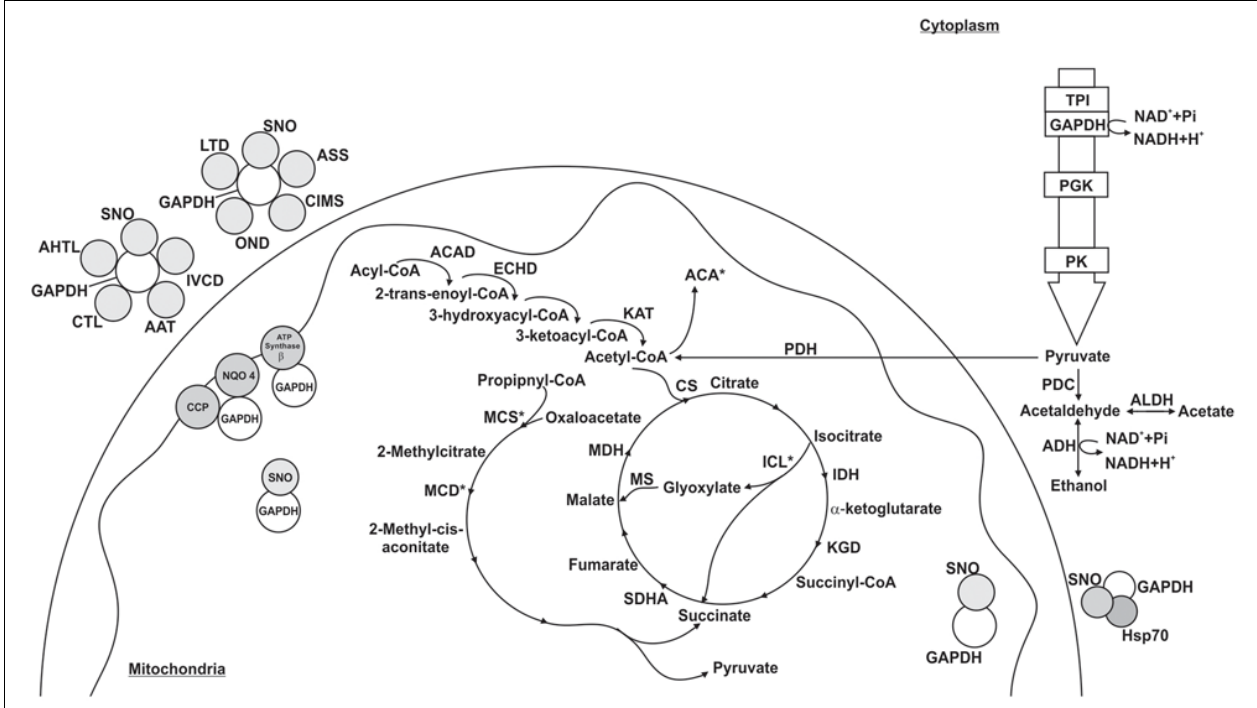
FIGURE 5 | Schematic model of the metabolic processes involving GAPDH through PPI in P. lutzii yeast phase. All proteins shown in the figures interacted with GAPDH. GAPDH (glyceraldehyde-3-phosphate dehydrogenase), SNO (nitrosylation), ACAD (acyl-CoA dehydrogenase), ECHD (enoyl-CoA hydratase), KAT (3-ketoacyl-CoA thiolase), CS (citrate synthase), IDH (isocitrate dehydrogenase), ICL (isocitrate lyase), KGD (dihydrolipoyl dehydrogenase), SDHA (succinate dehydrogenase flavoprotein subunit), MDH (malate dehydrogenase), MCS (2-methylcitrate synthase), MCD (2-methylcitrate dehydratase), TPI (triosephosphate isomerase), PGK (phosphoglycerate kinase), PK (pyruvate kinase), PDH (pyruvate dehydrogenase E1 component subunit β ), PDC (pyruvate decarboxylase), ADH (alcohol dehydrogenase), ALDH (aldehyde dehydrogenase), ACA (acetyl-CoA acetyltransferase), AHTL ( o -acetylhomoserine thiol-lyase), CTL (cystathionine γ -lyase), AAT (aspartate aminotransferase), IVCD (isovaleryl-CoA dehydrogenase), ASS (argininosuccinate synthase), CIMS (cobalamin-independent methionine synthase), OND (oxidoreductase 2-nitropropane dioxygenas), LTD (L-threonine 3-dehydrogenase), CCP (cytochrome c peroxidase) and NQO4